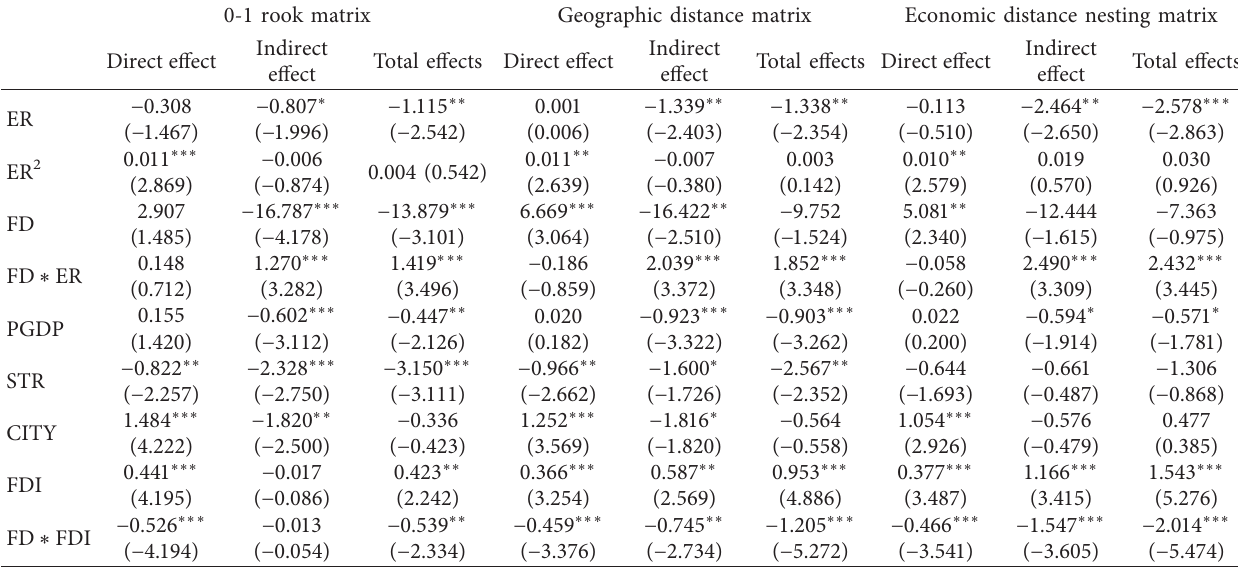
Table 6: The direct effects, indirect effects, and total effects of the spatial Durbin model (expenditure fiscal decentralization). 0-1 rook matrix Geographic distance matrix